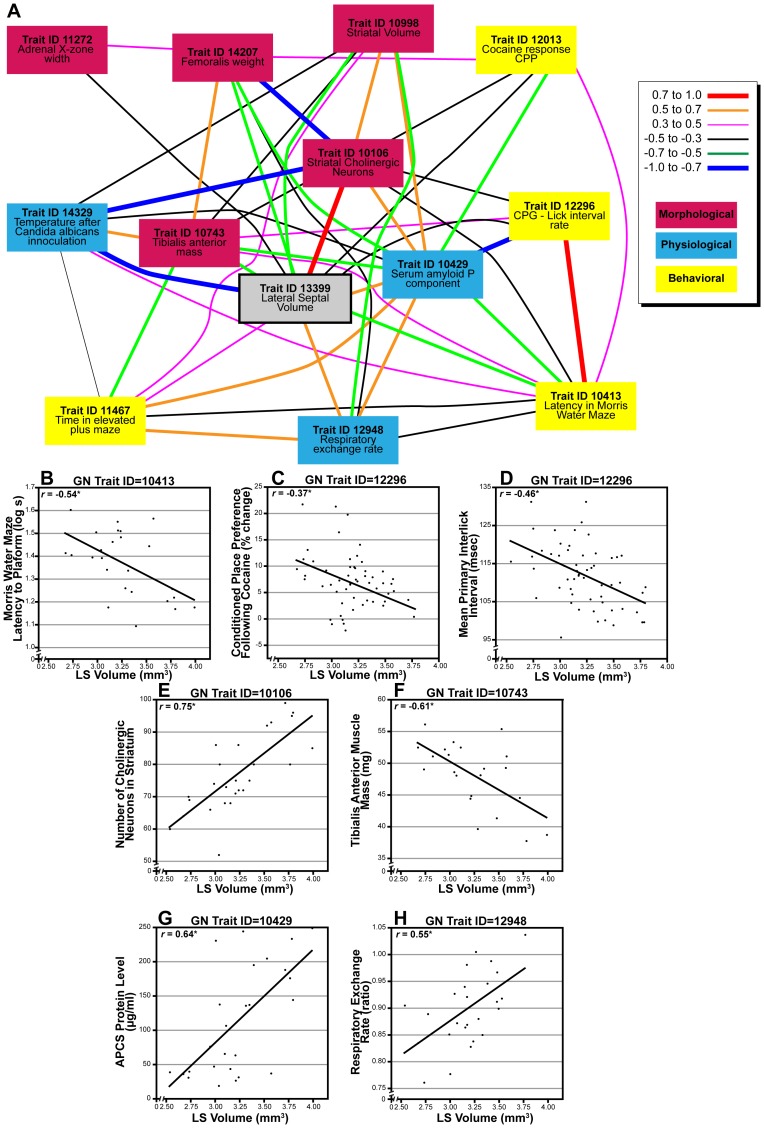
Covariation of LS volume with traits from the BXD Phenotype Database.
A. Gene network diagram illustrating covariation among LS volume (gray) and a collection of morphological (red), physiological (blue), and behavioral (yellow) traits. Legend indicates the strength of the correlation between the genes. B–H. Scatterplots of LS volume correlated with behavioral (B-D), morphological (E,F) and physiological (G,H) traits.